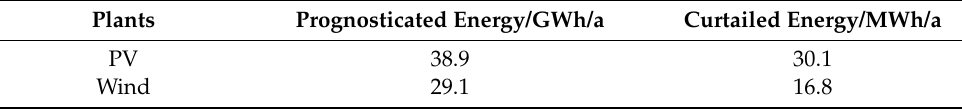
Table 16. Results of the planning variant dynamic